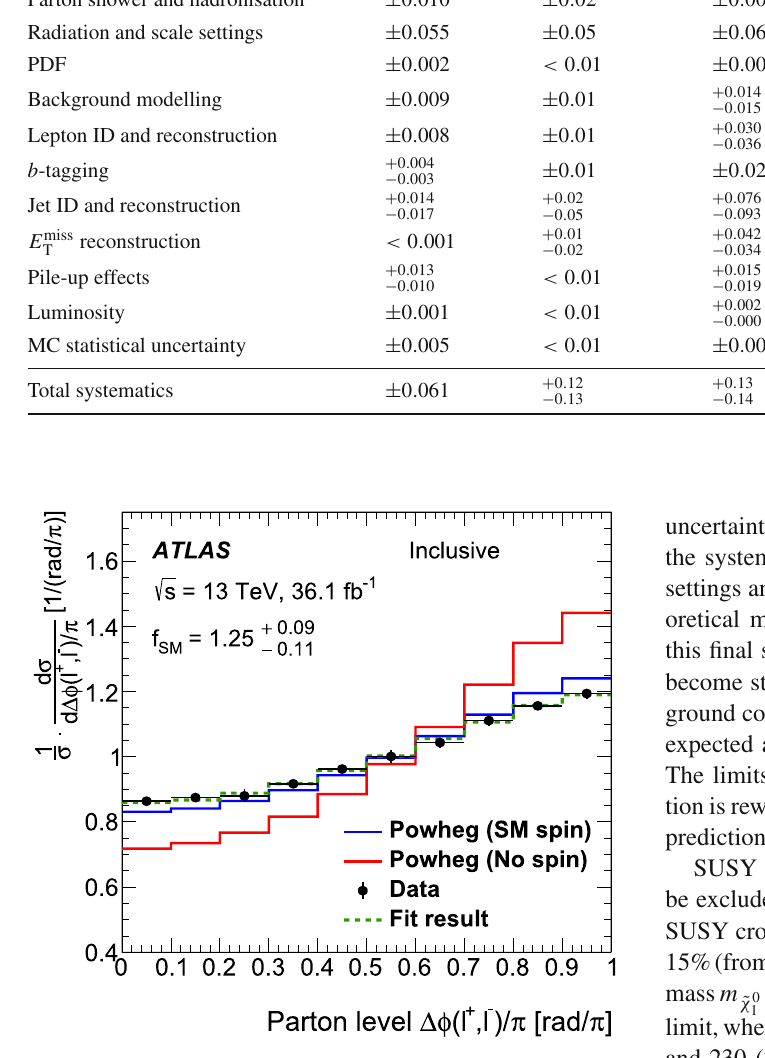
Fig. 11 Results of the fit of hypothesis templates to the unfolded data showing the (cid:3)φ distribution for the inclusive selection. The hypothesis templates are described in Sect.